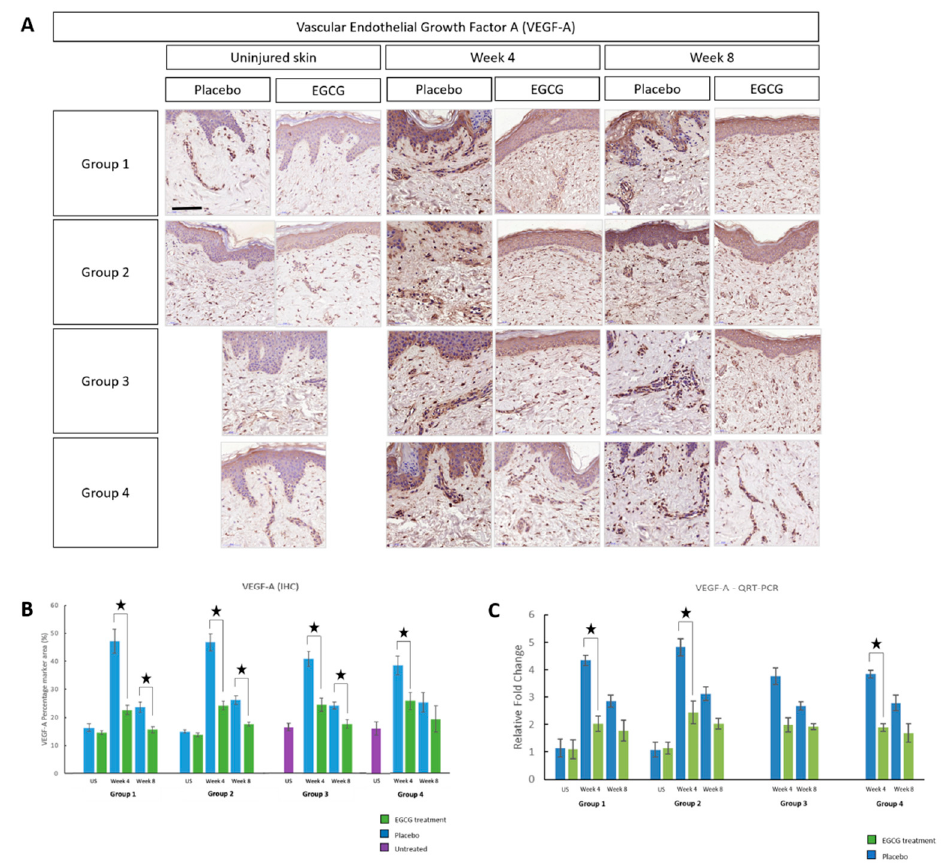
Figure 18. Angiogenesis marker Vascular Endothelial Growth Factor A (VEGF-A) analysis of topical epigallocatechin-3-gallate (EGCG) versus placebo. ( A ) VEGF-A images also confirmed a decrease in EGCG samples compared to placebo. ( B ) VEGF-A (epidermal and dermal) percentage marker area measurements. ( C ) QRT-PCR of VEGF-A. Significance: ★ p ≤ 0.01. Error bars: mean ± SD. Scale bars = 50 μ m.